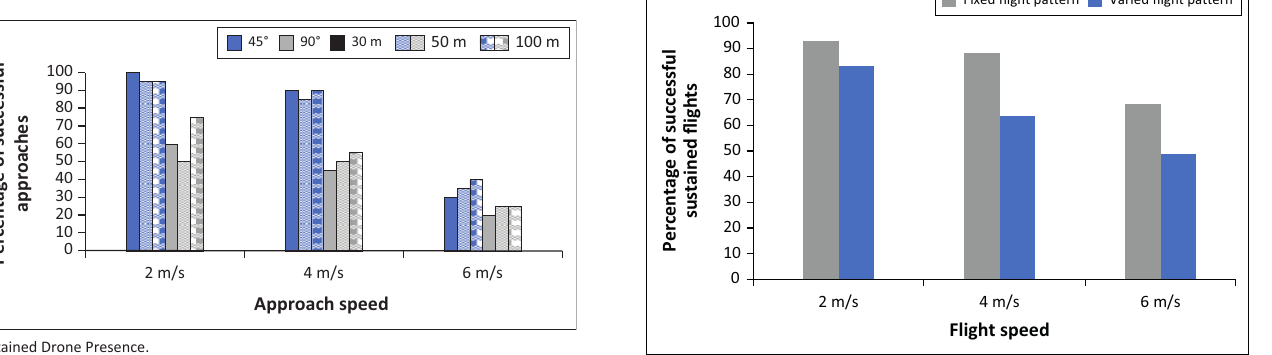
FIGURE 4: The percentage of successful presence flights, regardless of elephant category, when broken down by Flight Speed (2, 4 or 6 m/s) and Flight Pattern (Fixed or